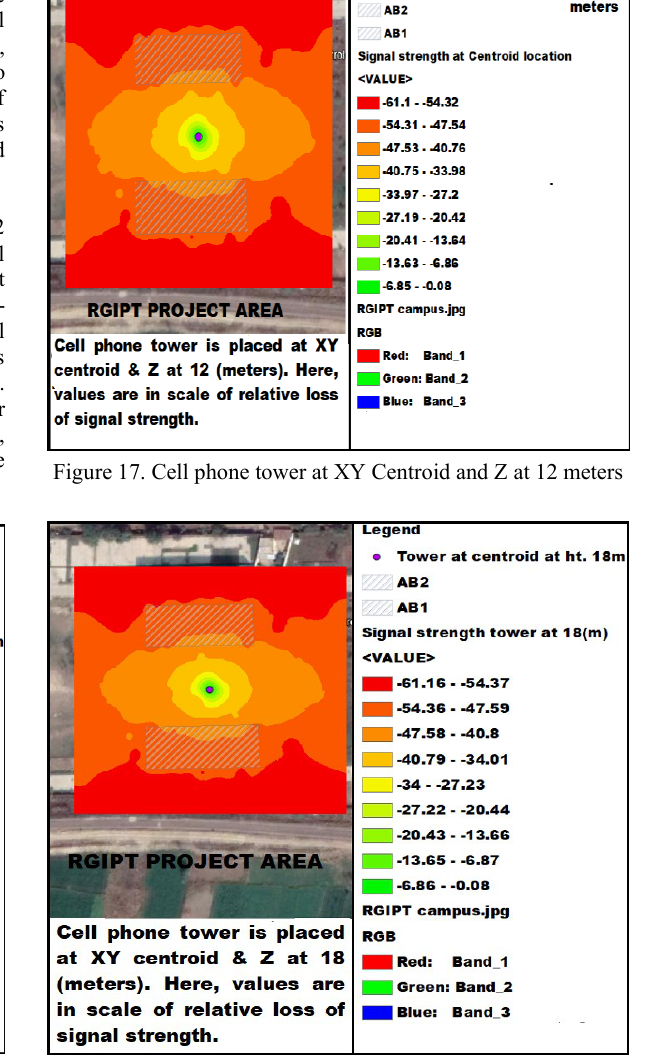
Figure 18. Cell phone tower at XY Centroid and Z at 18 meters.